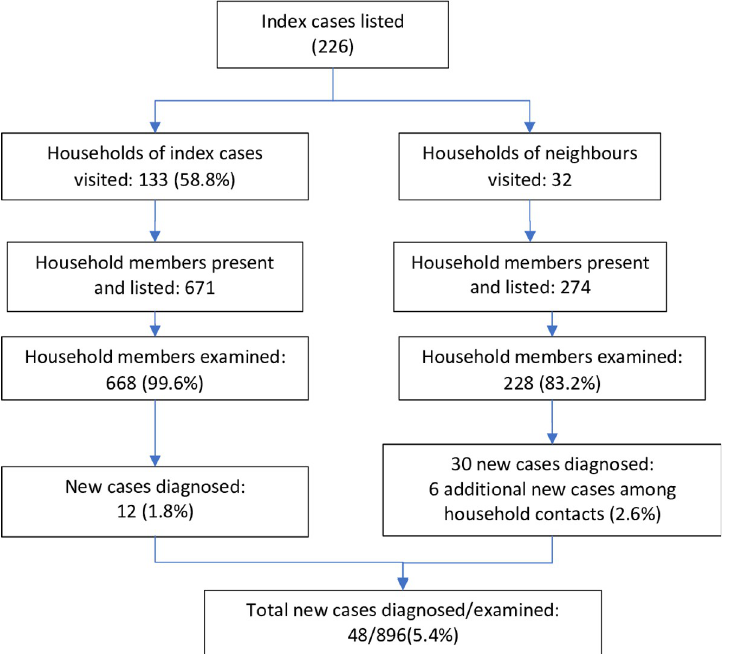
Fig 1. Flowchart of households screened for leprosy, Anjouan, December 2020.